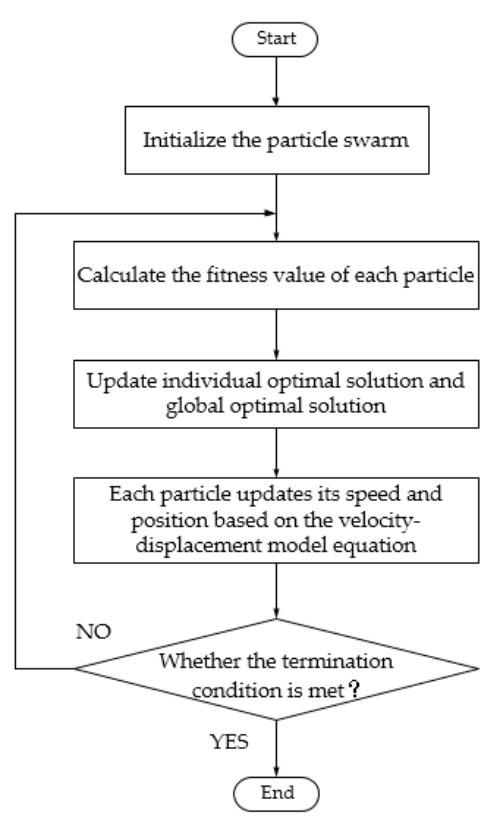
Figure 8. A standard PSO flow chart.